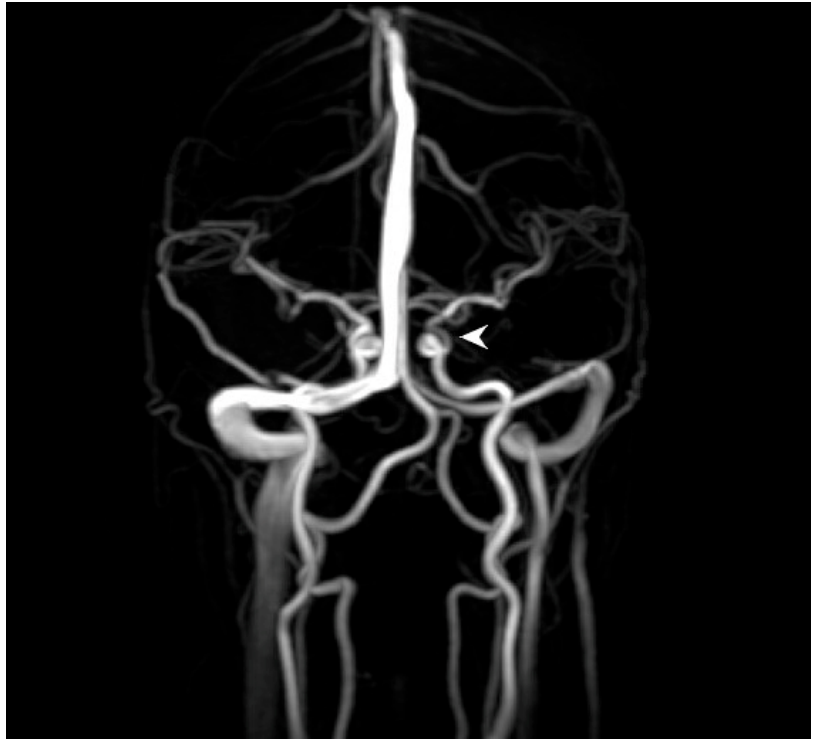
Figure 1. Brain magnetic resonance angiography (MRA) immediately prior to ophthalmic examina- tion shows anticipated changes from the recent revascularization procedure with persistent filling of the 2 mm supraclinoid segment aneurysm (arrowhead), without other abnormalities of the major intracranial vasculature.